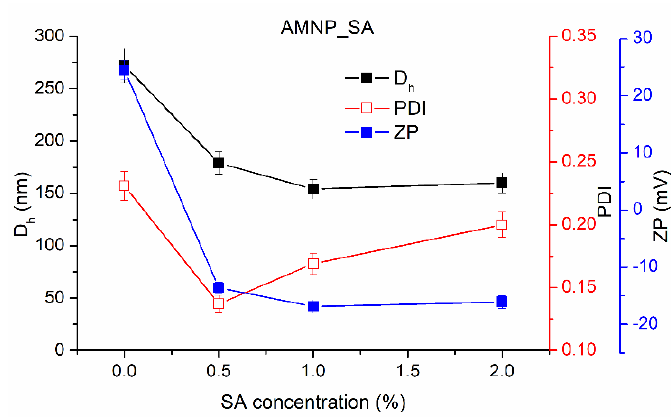
Figure 3. Variation of D h , PDI and ZP with the SA concentration used in the functionalization of MNPs.